Question: What form of chart is displayed?
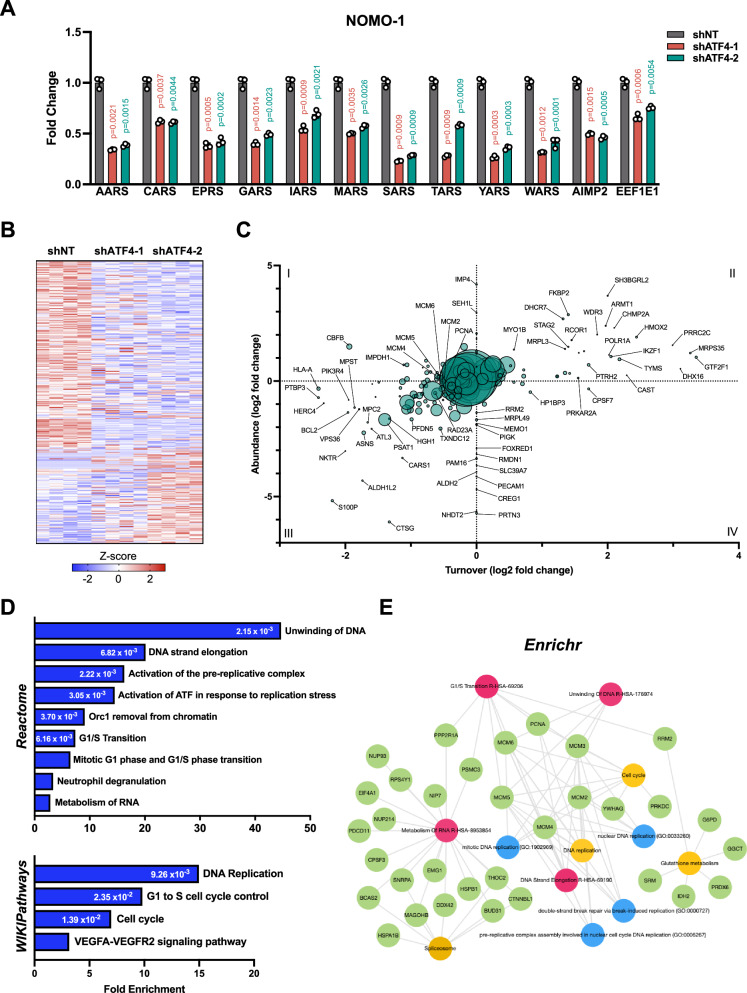
Answer: heatmap